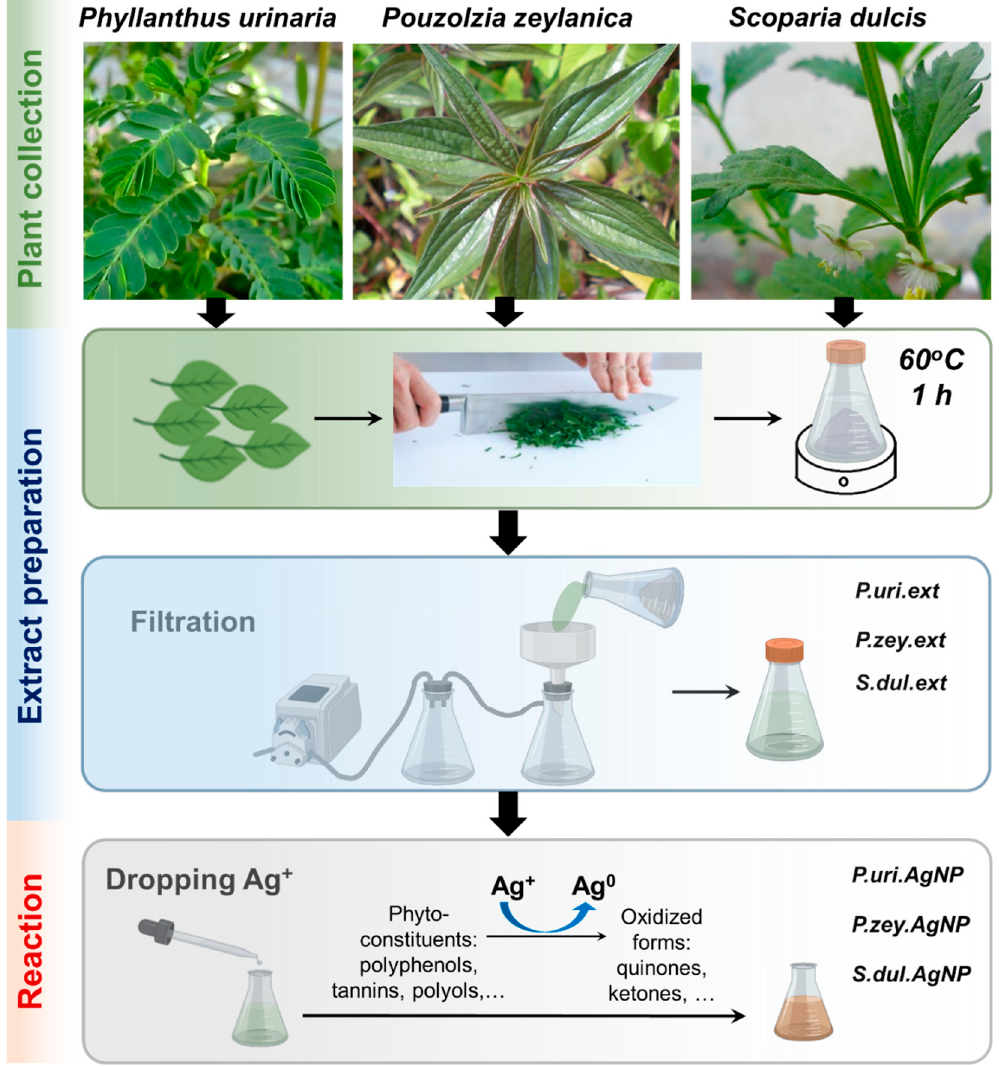
Figure 1. Biosynthesis procedure of silver nanoparticles using various plant extracts: Phyllanthus urinaria , Pouzolzia zeylanica, and Scoparia dulcis leaf extracts symbolized as P.uri.ext, P.zey.ext, and S.dul.ext were reacted with silver nitrate to form three types of silver nanoparticles that were named as P.uri.AgNP, P.zey.AgNP, and S.dul.AgNP, respectively.